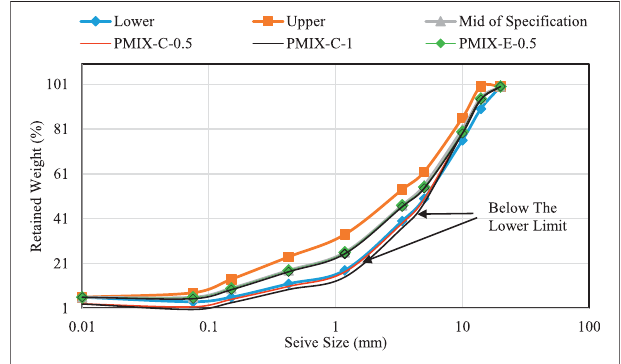
FIGURE 4 | Upper and lower limits and the obtained aggregate gradation.